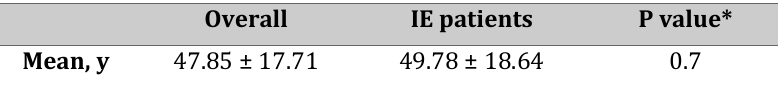
Table 1 . Age differences between patients with BE patients and overa.